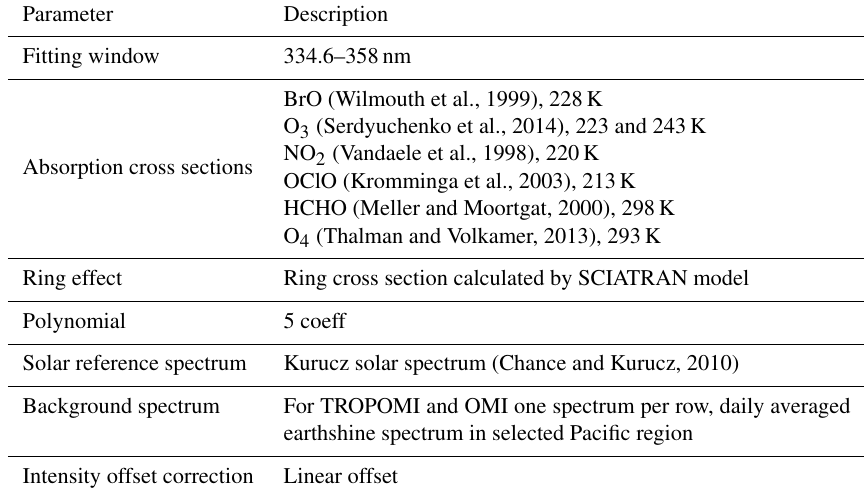
Table 2. DOAS settings used for the BrO slant column retrievals and instrumental